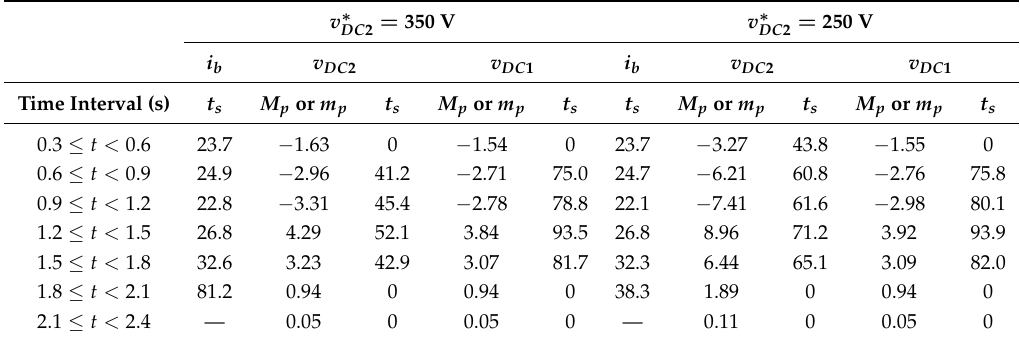
Table 10. Overshoot ( M p > 0 (%)) or undershoot ( m p < 0 (%)), and 2%-settling time ( t s (ms)) in the G2V mode for i b , v DC 2 , and v DC 1 considering k = 0.7 k n .